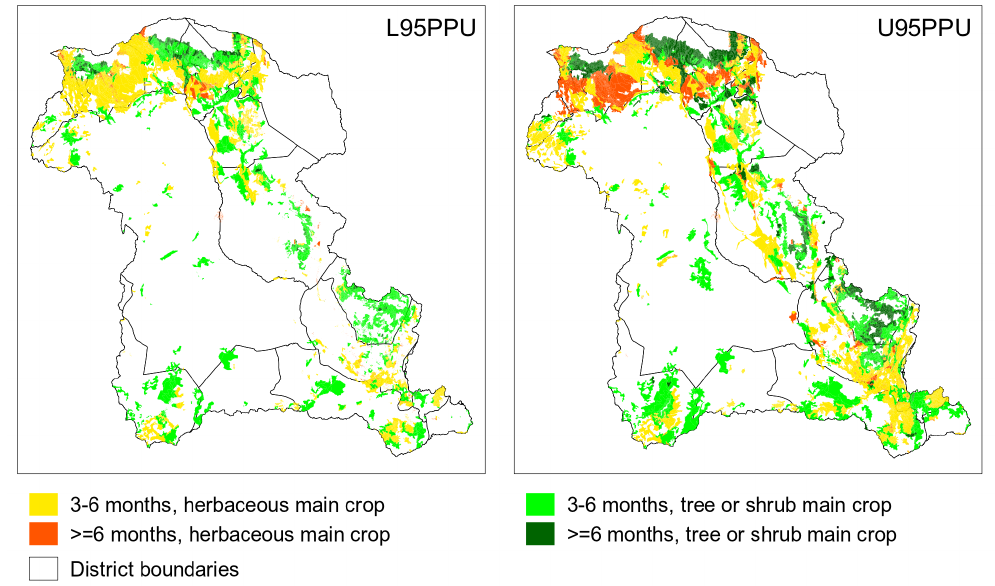
Fig. 7. Duration of the growing period (GP) reached on cropland at 75% reliability, differentiated by herbaceous (temporary) and tree or shrub (permanent) crops. Left panel: lower 95% prediction uncertainty boundary (L95PPU); right panel: upper 95% prediction uncertainty boundary (U95PPU).